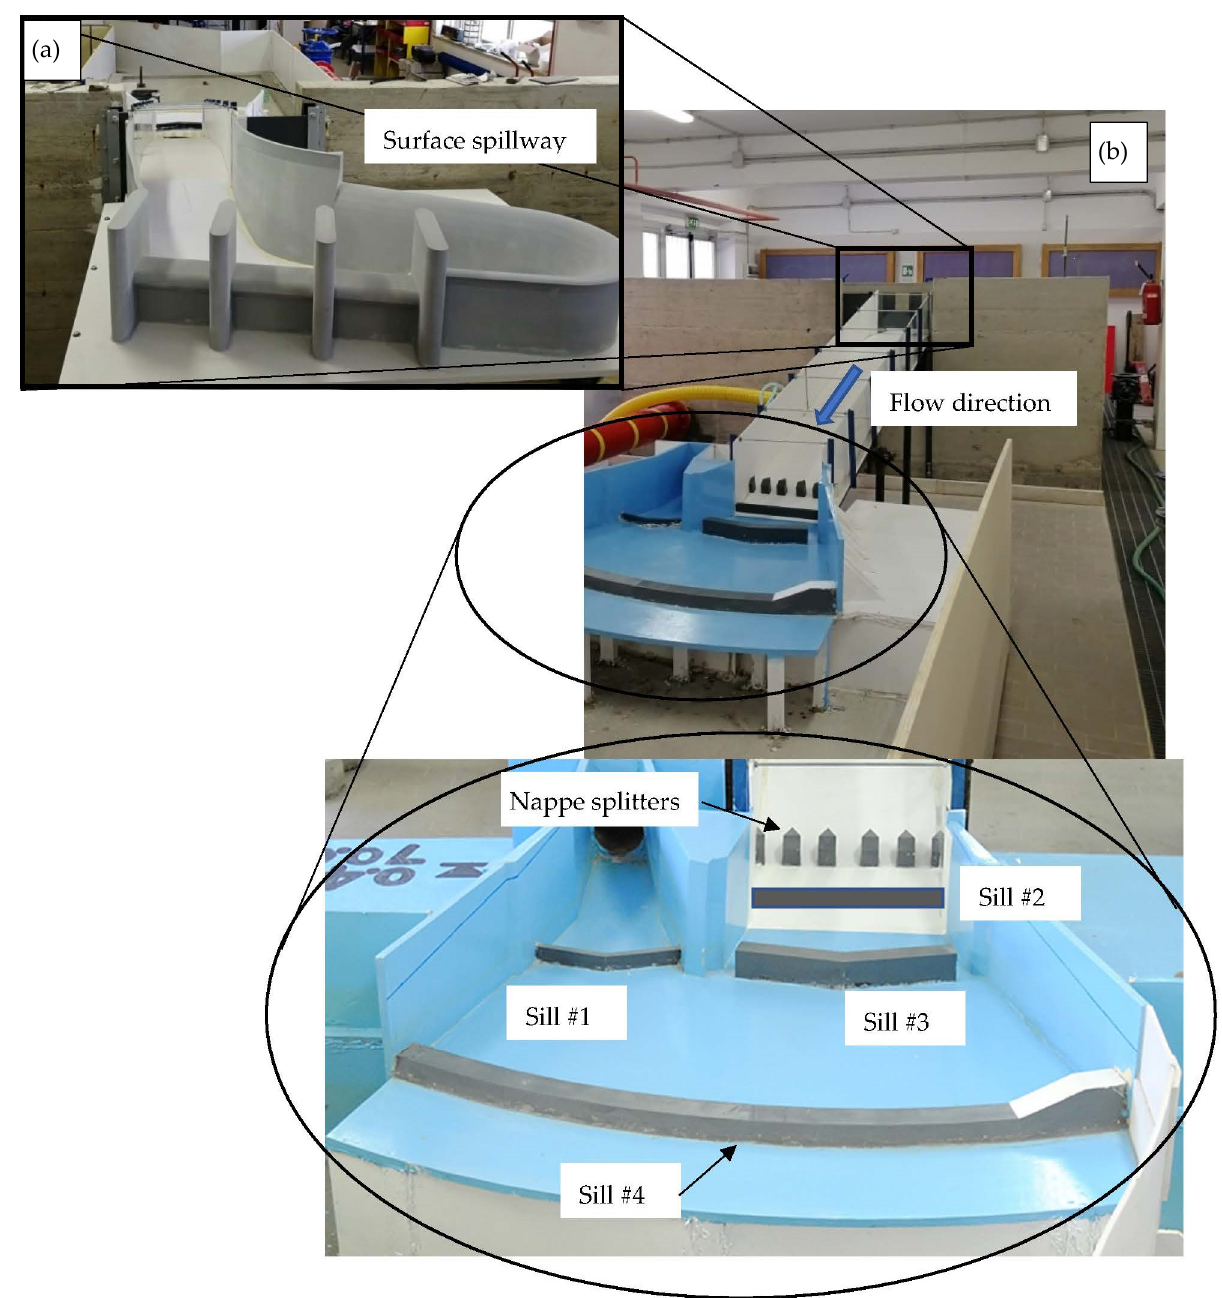
Figure 5. Physical mode: ( a ) surface spillway; ( b ) chute, bottom outlet terminus, sills and stilling basin.